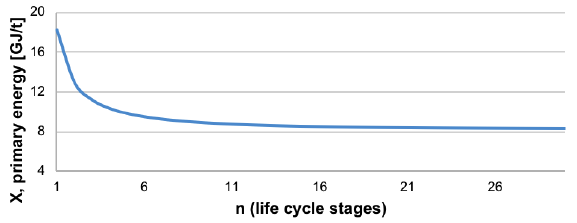
Figure 13. Steel scrap embodied energy ( X = 8.2) for electric arc furnace (EAF) recycling route.